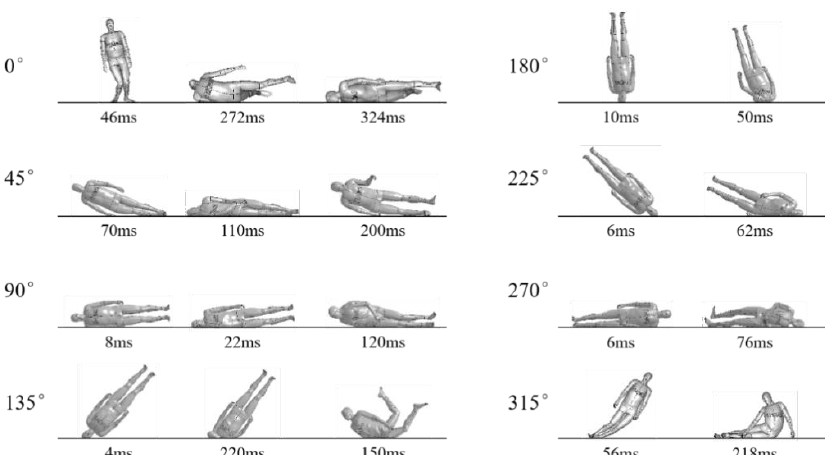
Figure 4. Typical landing kinematics in PFOx−.